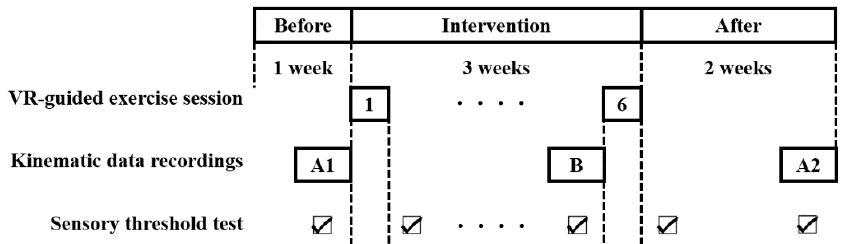
Figure 1. Experimental design. A1 phase, 1 week before intervention; B phase, 3-week intervention (twice-a-week exercise); A2 phase, 2 weeks after the intervention. Kinematic data during gait are recorded at the end of each phase, and the sensory test is conducted before and after each exercise session.